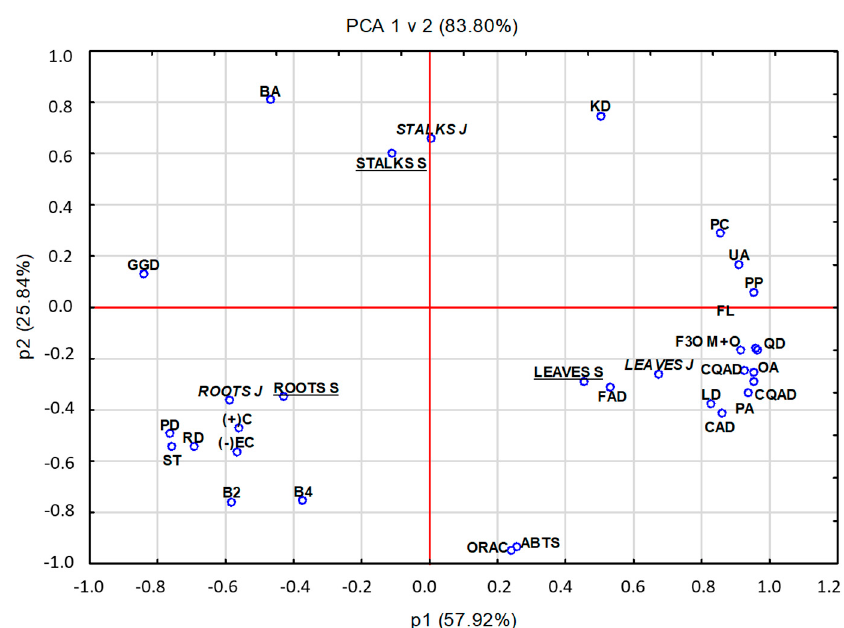
Figure 3. Principal component analysis (PCA) showing the relationship among phenols and antioxidative activity in leaves, stalks, and roots of Fallopia species. Explanation : BA, betulinic acid; UA, ursolic acid, OA, oleanolic acid; ORAC, oxygen radical absorbance capacity; ABTS, radical scavenging capacity; PP, polymeric procyanidin; PA, phenolic acid; FL, flavonols, PC, phenolic compounds; ( + )C, ( + )-Catechin; ( − )EC, ( − )-epicatechin; B2, procyanidin B dimer; B4, procyanidin B tetramer; F3O M + O; flavan-3-ols monomeric and oligomeric; LD, luteolin compounds, RD, resveratrol compounds; ST, total stilbene; PD, piceid compounds; FAD, feruloylquinic acid; CAD, caffeoylquinic acid; CQAD, coumaroylquinic acid; QD, quercetin compounds; KD; kaempferol; GGD, Galloyl glucose compounds; leaves S, roots S, stalk S; parts belonging to Fallopia sachalinensis (F.Schmidt); leaves J, roots J, stalk J, parts belonging to Fallopia japonica (Houtt).